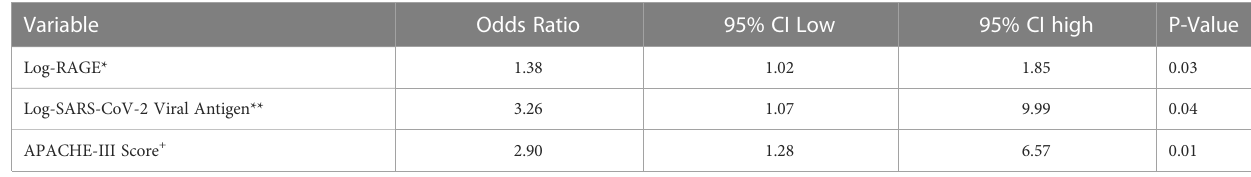
TABLE 3 Multivariable model for risk factors for development of severe disease or death at 7 Days.